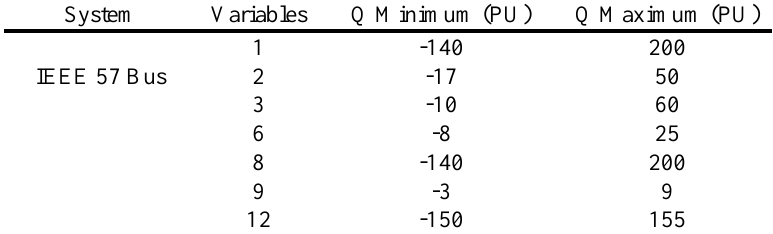
Table 8. Constrains of reactive power generators.